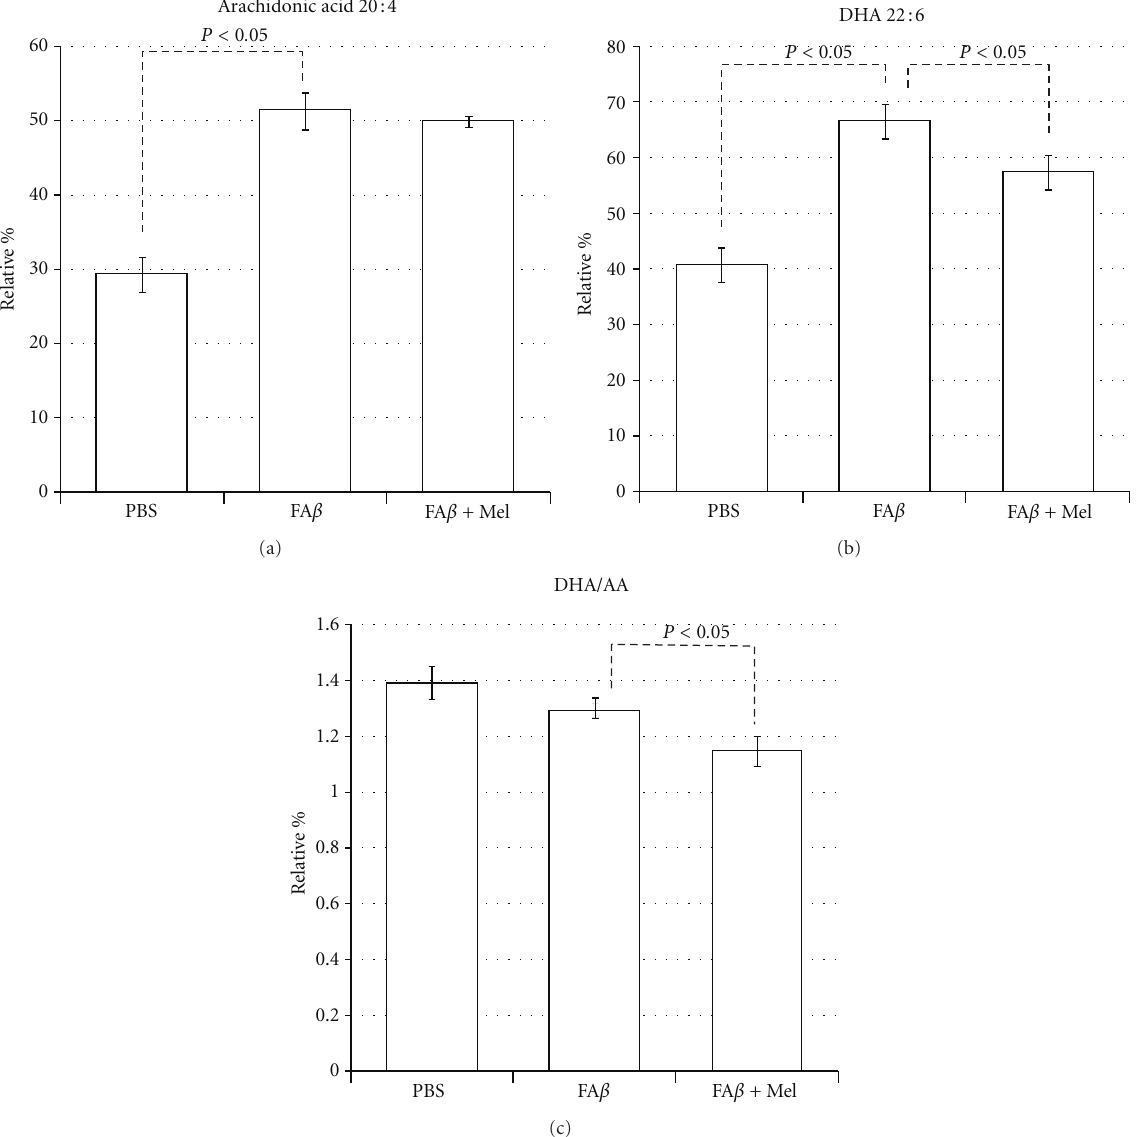
Figure 6: A β and H 2 O 2 (not shown) produced important increases in both n6 and n3 PUFA, which reflects the previous described changes in free fatty acids. A similar increase in DHA and AA allowed the DHA/AA ratio to remain stable, when compared with the PBS group. It is obvious that melatonin reduces the DHA/AA ratio, particularly at the expense of a decrease in DHA